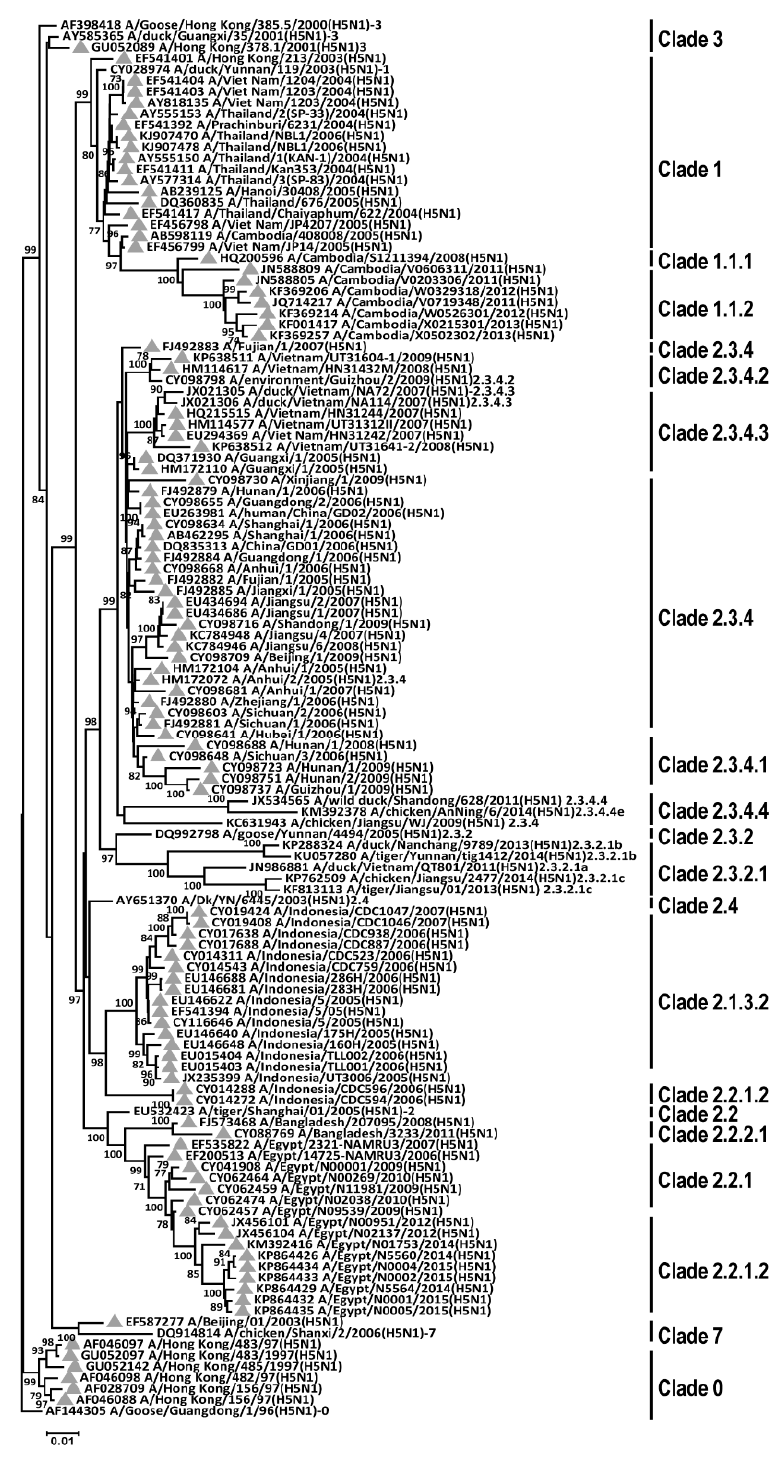
Figure 1. Phylogenetic analysis of the HA gene of avian H5N1 influenza viruses. The full-length of HA nucleotide sequences from different clades of avian H5N1 viruses were obtained via NCBI Influenza Virus Resource. The nucleotide sequences of complete HA-genes of avian H5N1 viruses were aligned, edited, and analyzed using ClustalW software. The phylogenetic analysis was per- formed using MEGA version X (http://www.megasoftware.net/). Consensus neighbor-joining trees were obtained from 1000 bootstrap replicates. The grey-filled triangles indicate avian H5N1 strains isolated from human.